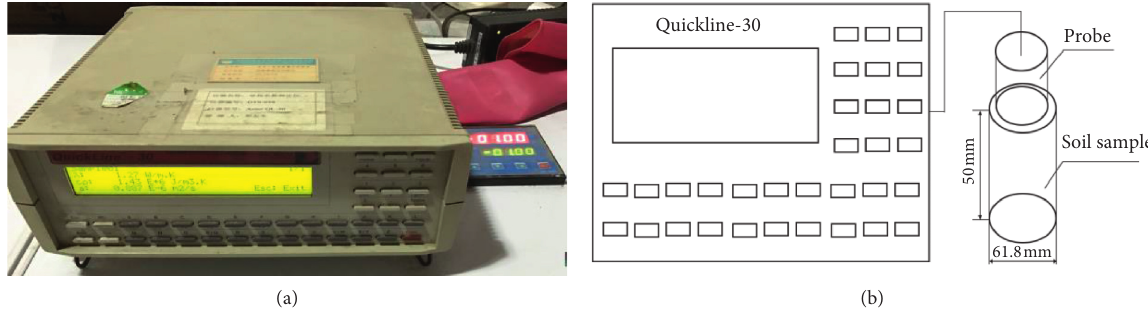
Figure 3: Experiment apparatus for thermal conductivity. (a) Photograph. (b) Schematic diagram. 2.0